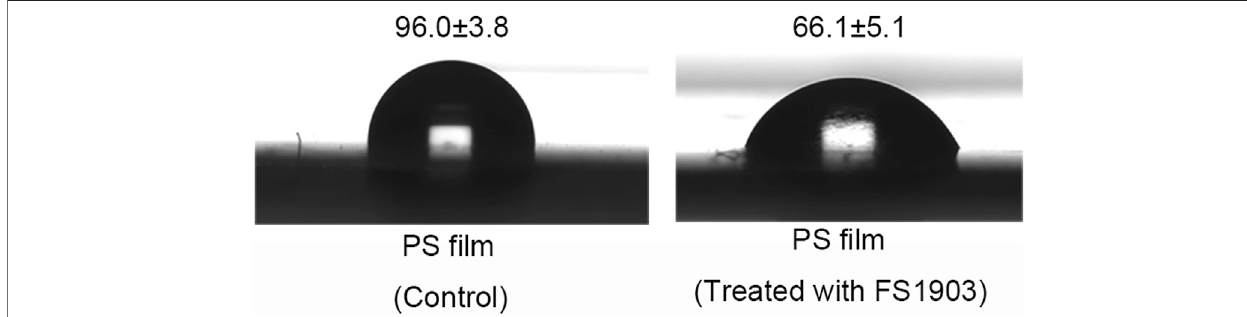
FIGURE 6 | WCA of PS fi lm without or with inoculation by strain FS1903.